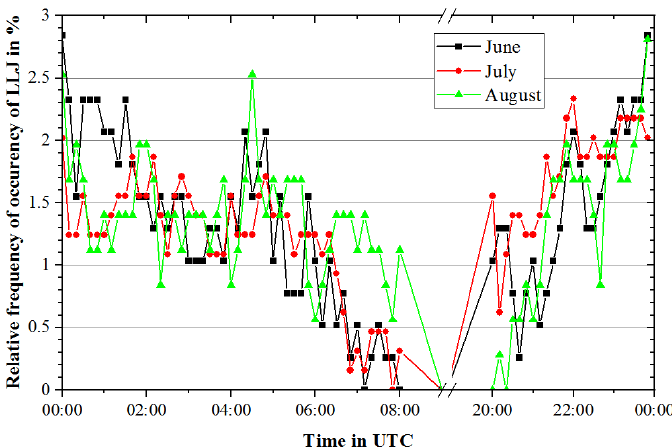
the summer months June, July and August 2013.